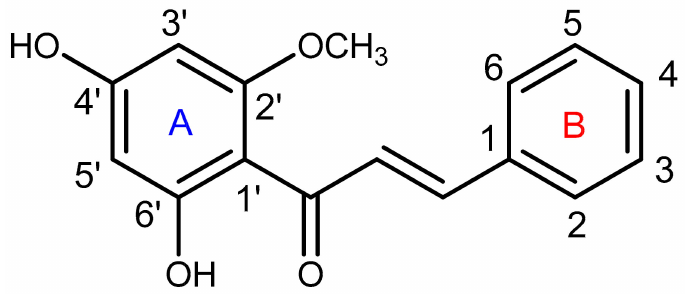
Figure 6. The chemical Structure of